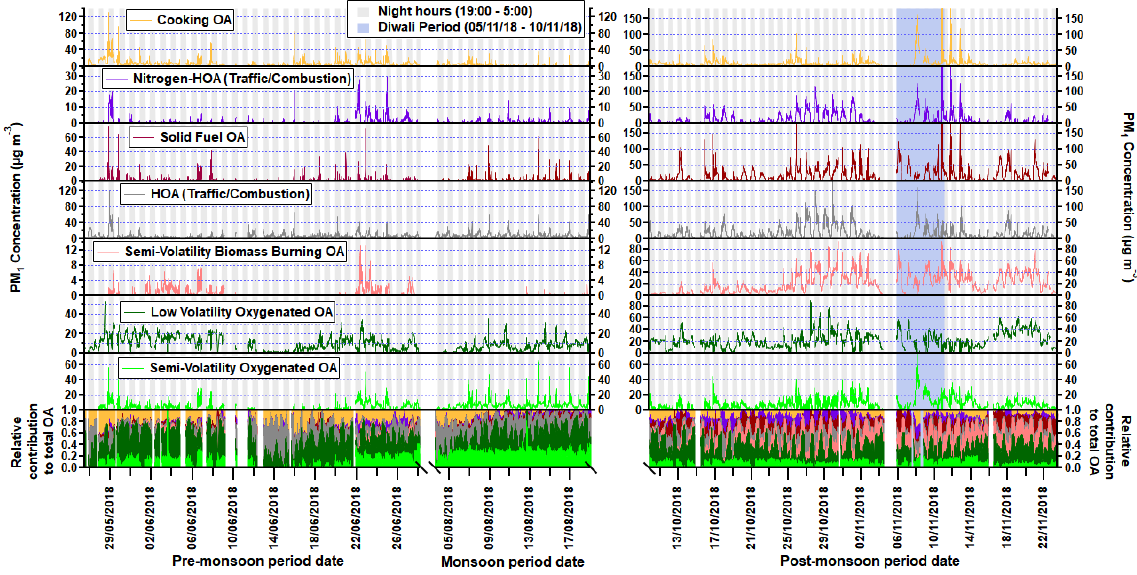
Figure 6. Time series for each factor where the x axis is broken to show each measurement period. Regions shaded in grey are night hours, and the Diwali period is shaded in light blue. The time series of the normalised concentrations are also shown in the bottom section of the